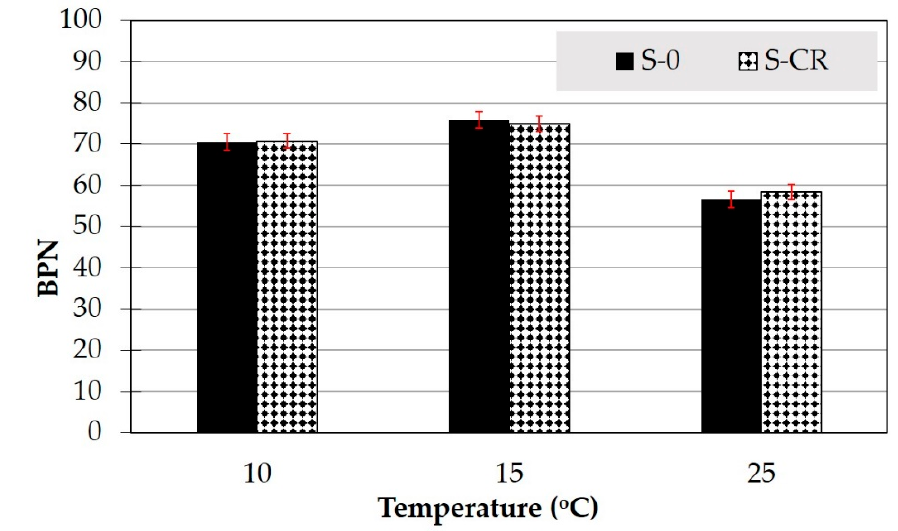
Figure 12. Temperature effect on the fabricated S-0 and S-CR specimens.